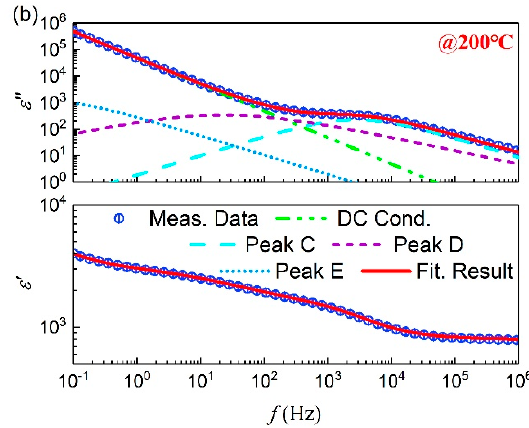
Figure 4. Dielectric responses of S1 before DC aging ( a ) − 100 ° C ( b ) 200 ° C.